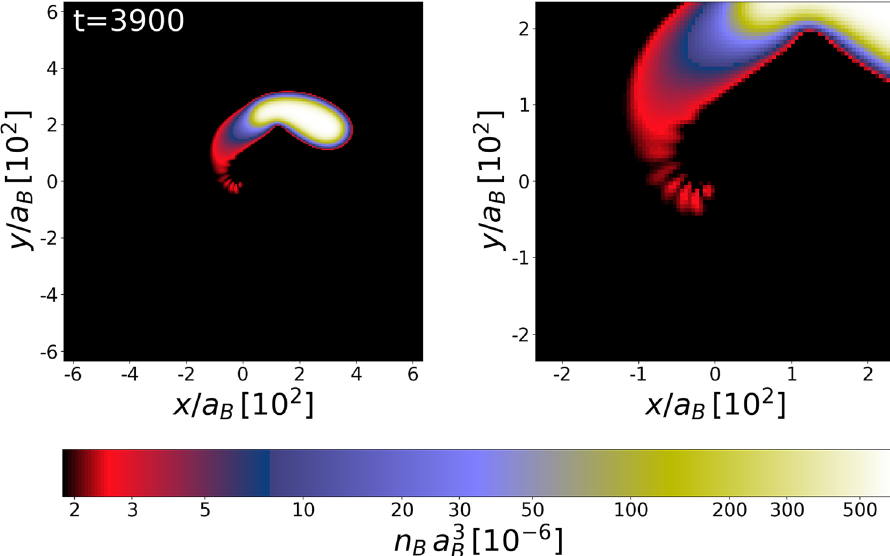
Figure 6. Grains of matter falling onto the black hole while the white dwarf is passing aside, along the hyperbolic orbit. A series of falling matter blocks (visible in red color) could be responsible for radiation of a train of ultraluminous flares. The right frame magnifies the central part of the left image. The unit of time is ( m B a 2 B )/ (cid:31)